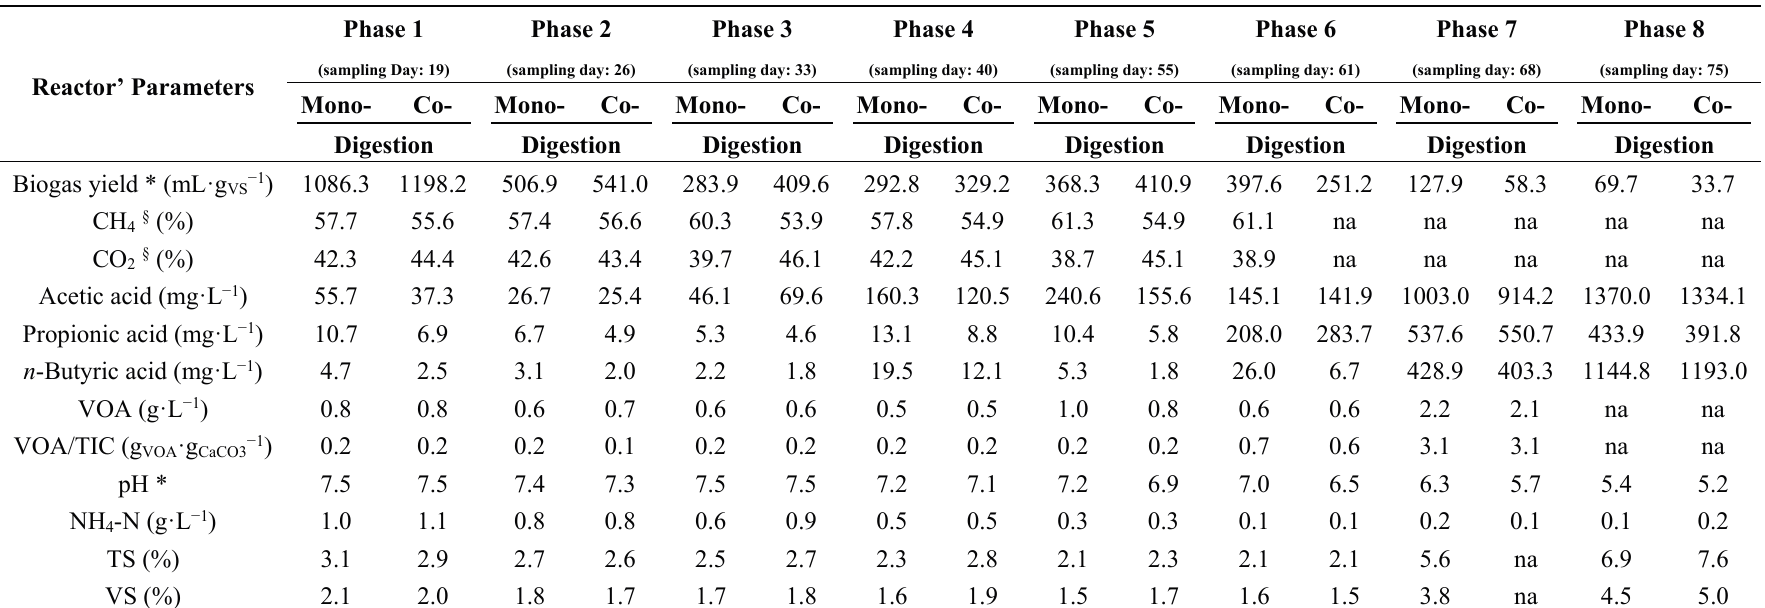
Table 1. Major reactor parameters along the eight phases of the experiment